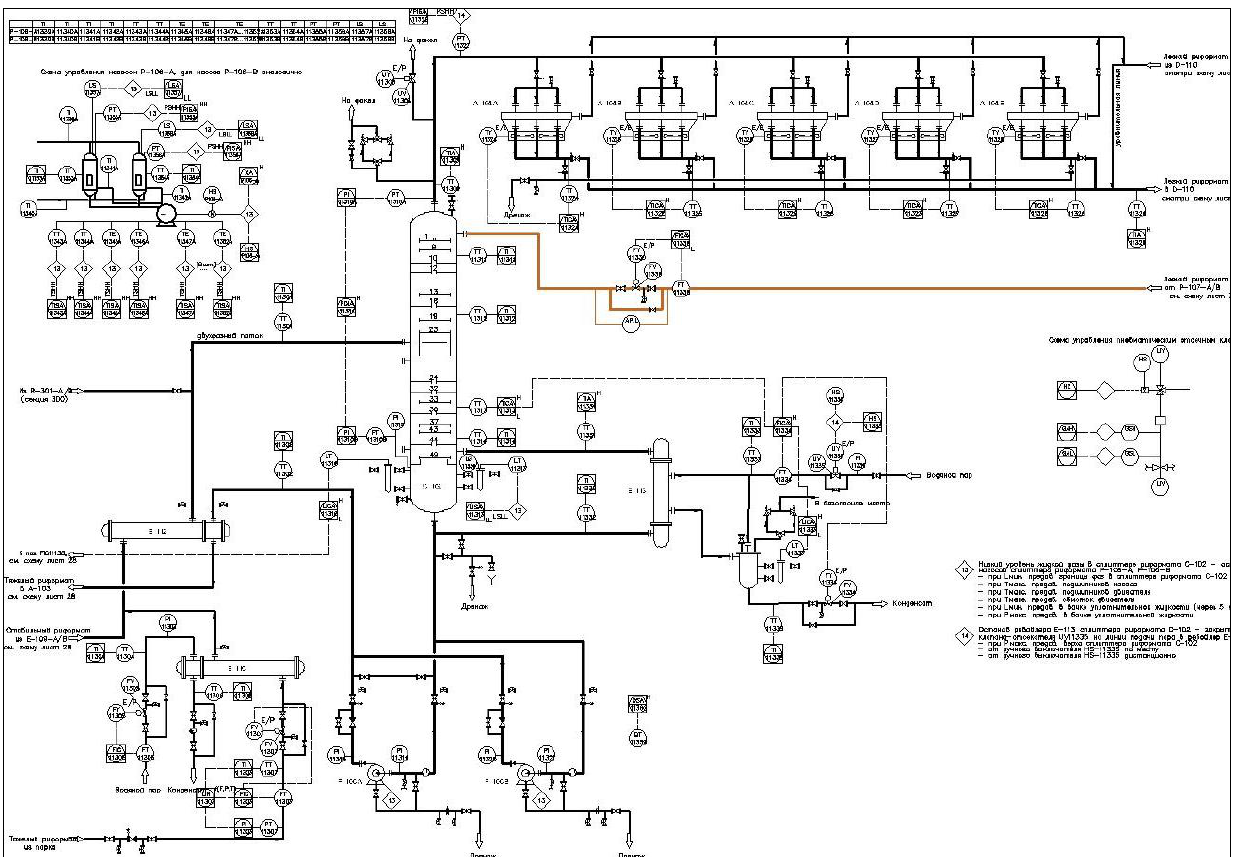
Figure 1 . Functional scheme of automation of rectification